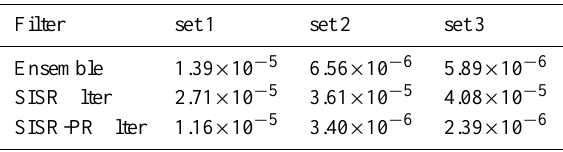
Table 3. RMSE [mms − 1 ] between the observed and simulated baseflow for 3 parameter sets. SISR-PR is applied with parameter